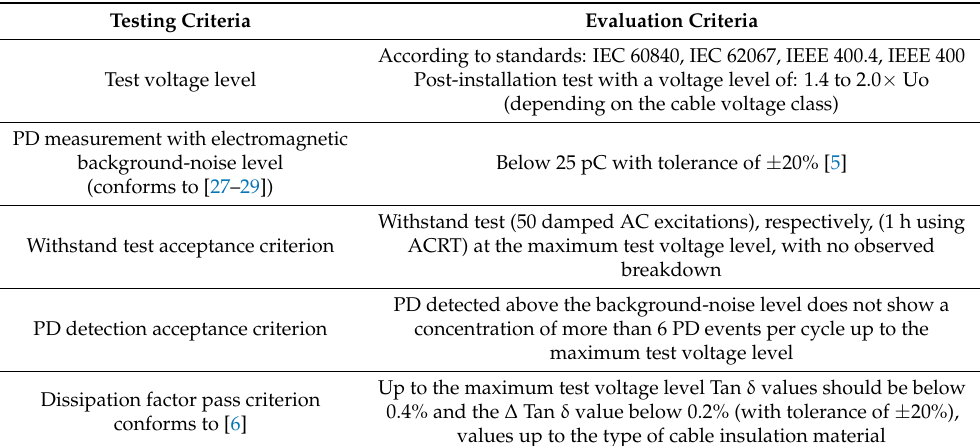
Table 6. Testing parameters and criteria for newly installed and service-aged long-length power cables with a cable voltage class up to 230 kV [12,13].